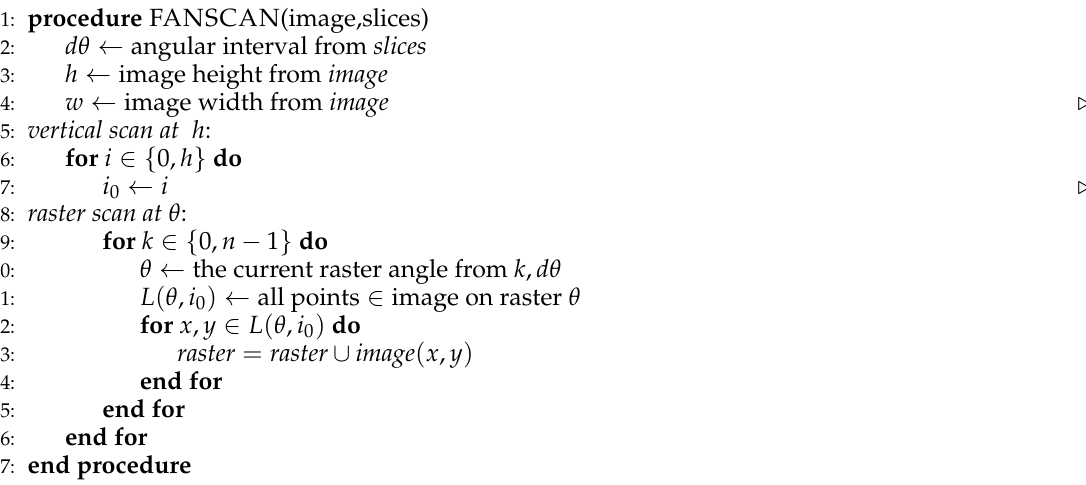
Algorithm 2 Pseudo code description of FANSCAN. Input = discretized radial image slices v N v